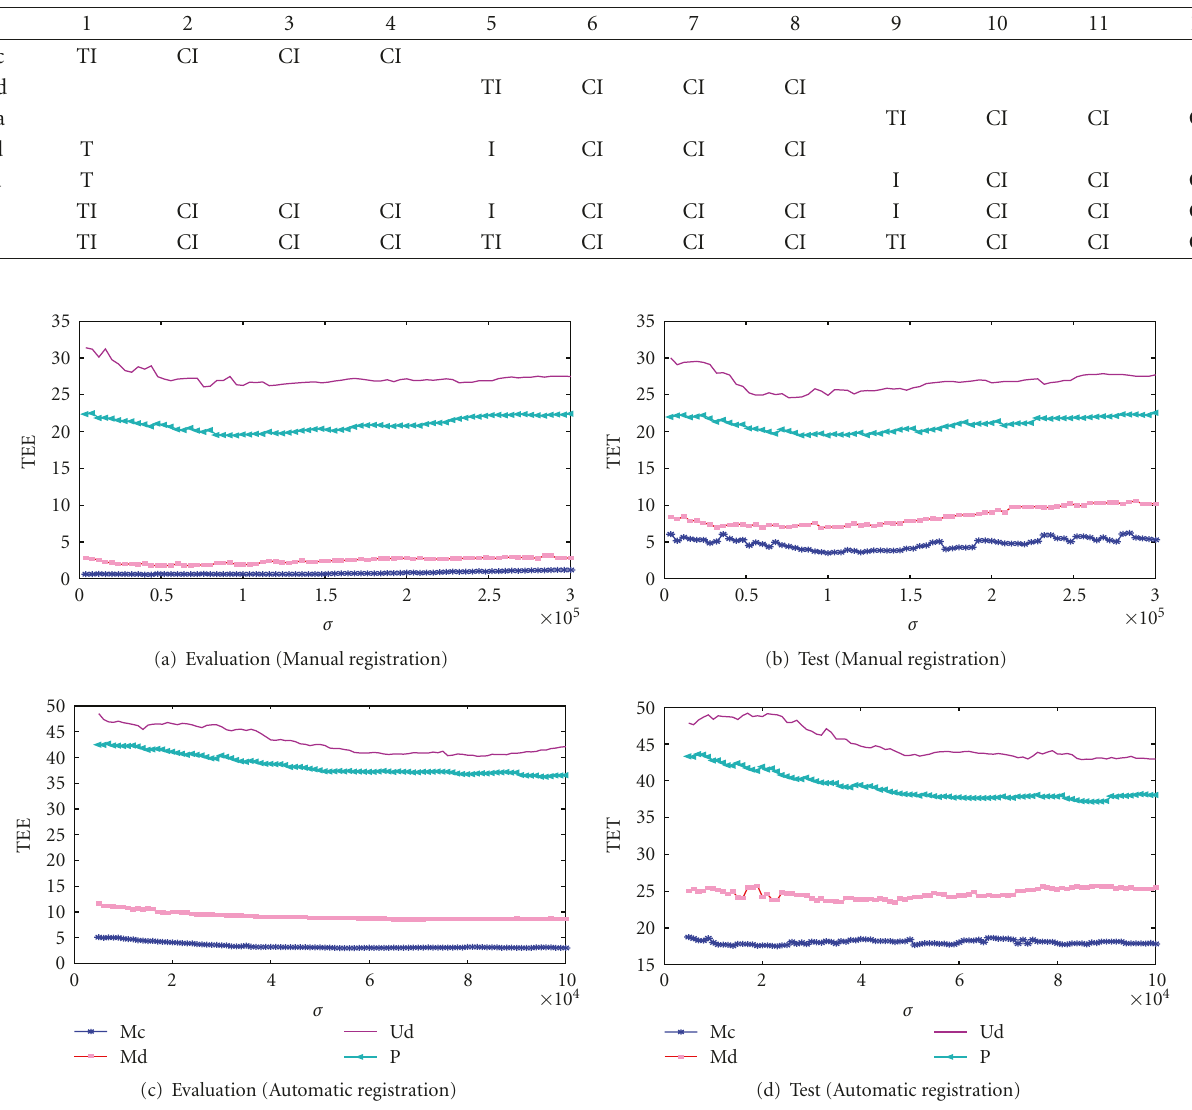
Table 1: The usage of the di ff erent sessions in the BANCA experimental protocols.